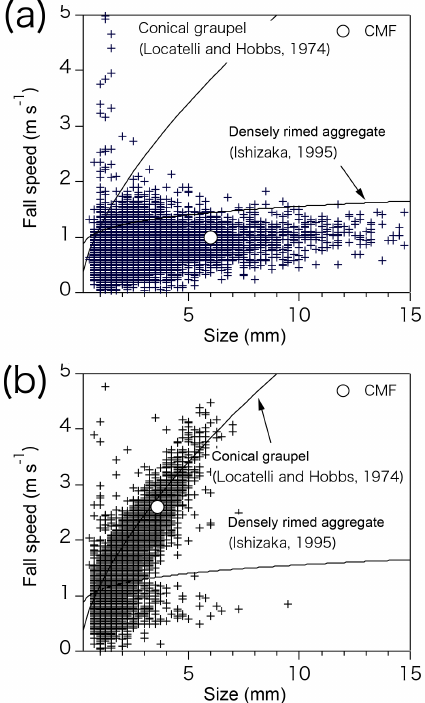
Figure 2. Distributions of measured size and fall speed (crosses), and integrated CMF (white circle) for different types of snowfall: (a) event A13 (aggregate type); and (b) event G4 (graupel type). Both cases are listed in Table 1. The two curves represent relation- ships for conical graupel (from Locatelli and Hobbs, 1974), and densely rimed aggregate (from Ishizaka,